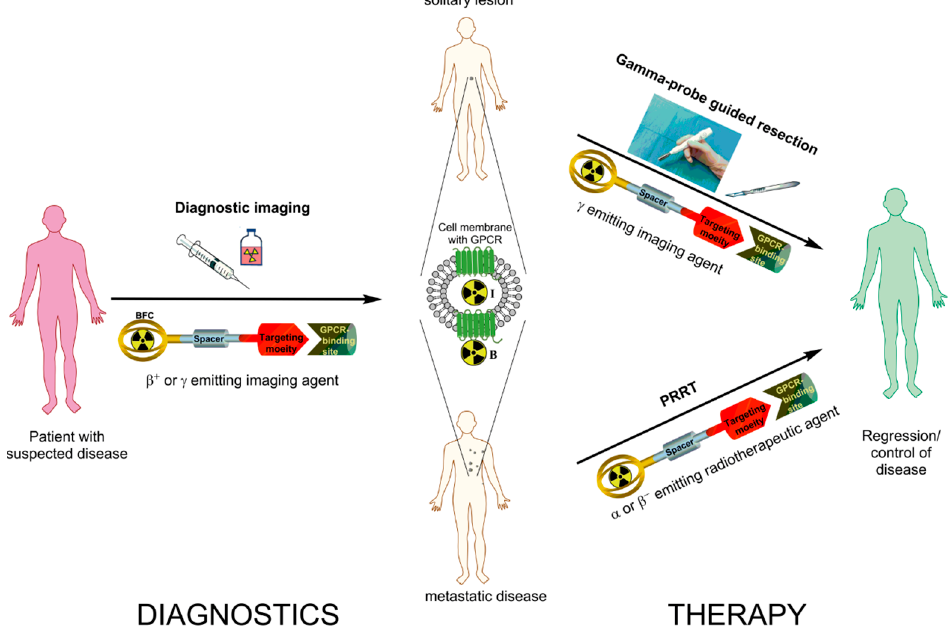
Figure 1. Schematic representation of radiotheranostics using radiolabeled peptides targeting G-protein coupled receptors (GPCR). The radiopharmaceutical consists of the targeting moiety (peptide), a bifunctional chelator (BFC) forming a stable complex with the radionuclide, and often a spacer in between the two units. Radiotheranostics involves diagnostic (left panel) and therapeutic (right panel) components. In targeting of GPCRs (somatostatin receptor (sstr), glucagon-like peptide-1 receptor (GLP-1R), cholecystokinin 2 receptor (CCK2R) or glucose-dependent insulinotropic polypeptide receptor (GIP-R); middle panel) the radiotheranostic agent would bind to GPCR and either internalize into the cell, when utilizing an agonist (I) or stay on the surface of the cell, when utilizing an antagonist (B). In the first step diagnostic imaging using β + or γ emitting imaging agent to assess the spread of disease is conducted. On the therapeutic stage, in the given example, the patient is subjected either to the gamma-probe guided resection or Peptide Receptor Radionuclide Therapy (PRRT). In radioguided surgery pre-administration of corresponding γ emitting imaging agent gives real-time information to the surgeon and guides the localization of the GPCR rich tumor site intraoperatively. In the case of a metastatic disease α or β − emitting radiotherapeutic agent is administered to target the GPCR rich lesions internally (PRRT).